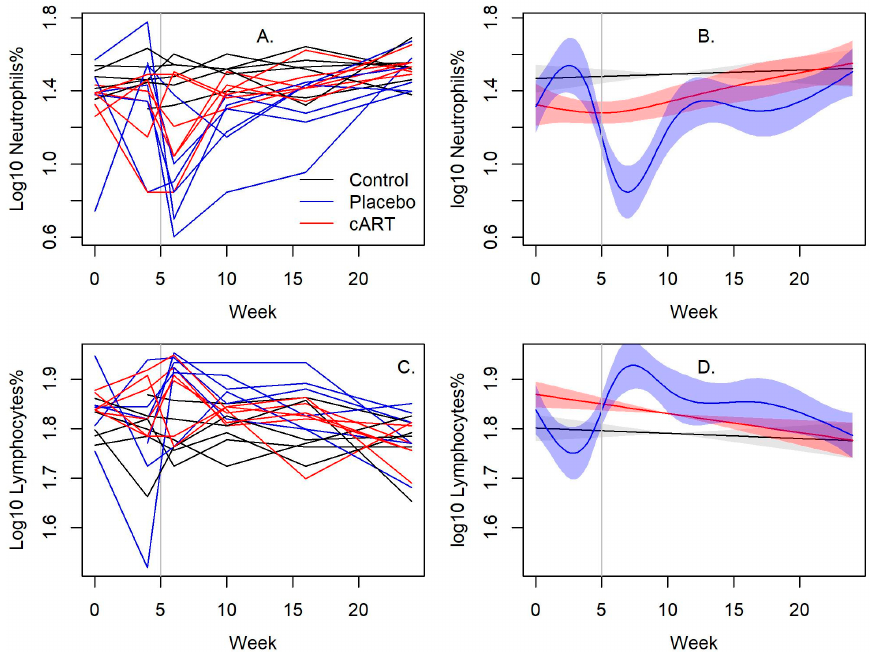
Figure 2. cART reduces myelosuppression of FIV infection. Neutrophil values in FIV+ cats treated with cART normalized by week 16, while placebo-treated FIV+ cats were persistently neutropenic ( p < 0.001). Lymphocyte values were normal in all groups but were lower in cART-treated FIV+ cats compared to placebo-treated FIV+ cats. The vertical bar indicates when cART and placebo treatment began. ( A , C ) Line plots of individual cats over time and ( B , D ) their associated spline fits from GAM analyses are